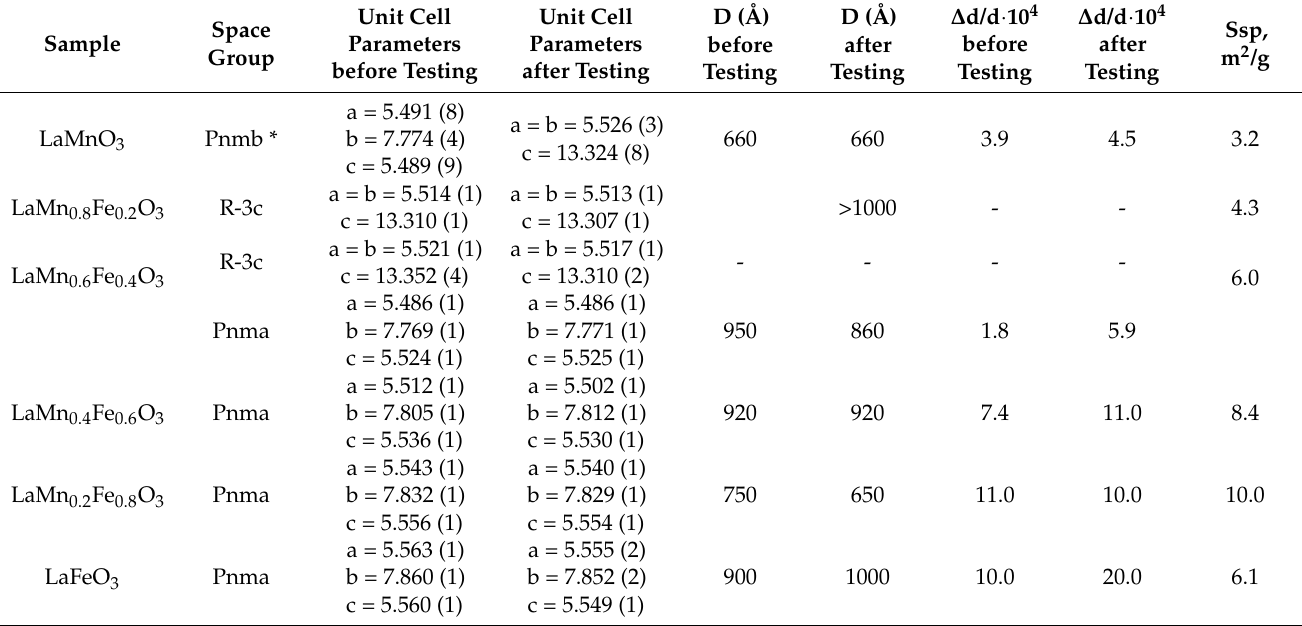
Table 1. X-ray diffraction analysis data for LaMn 1 − x Fe x O 3 perovskites before and after testing in methane